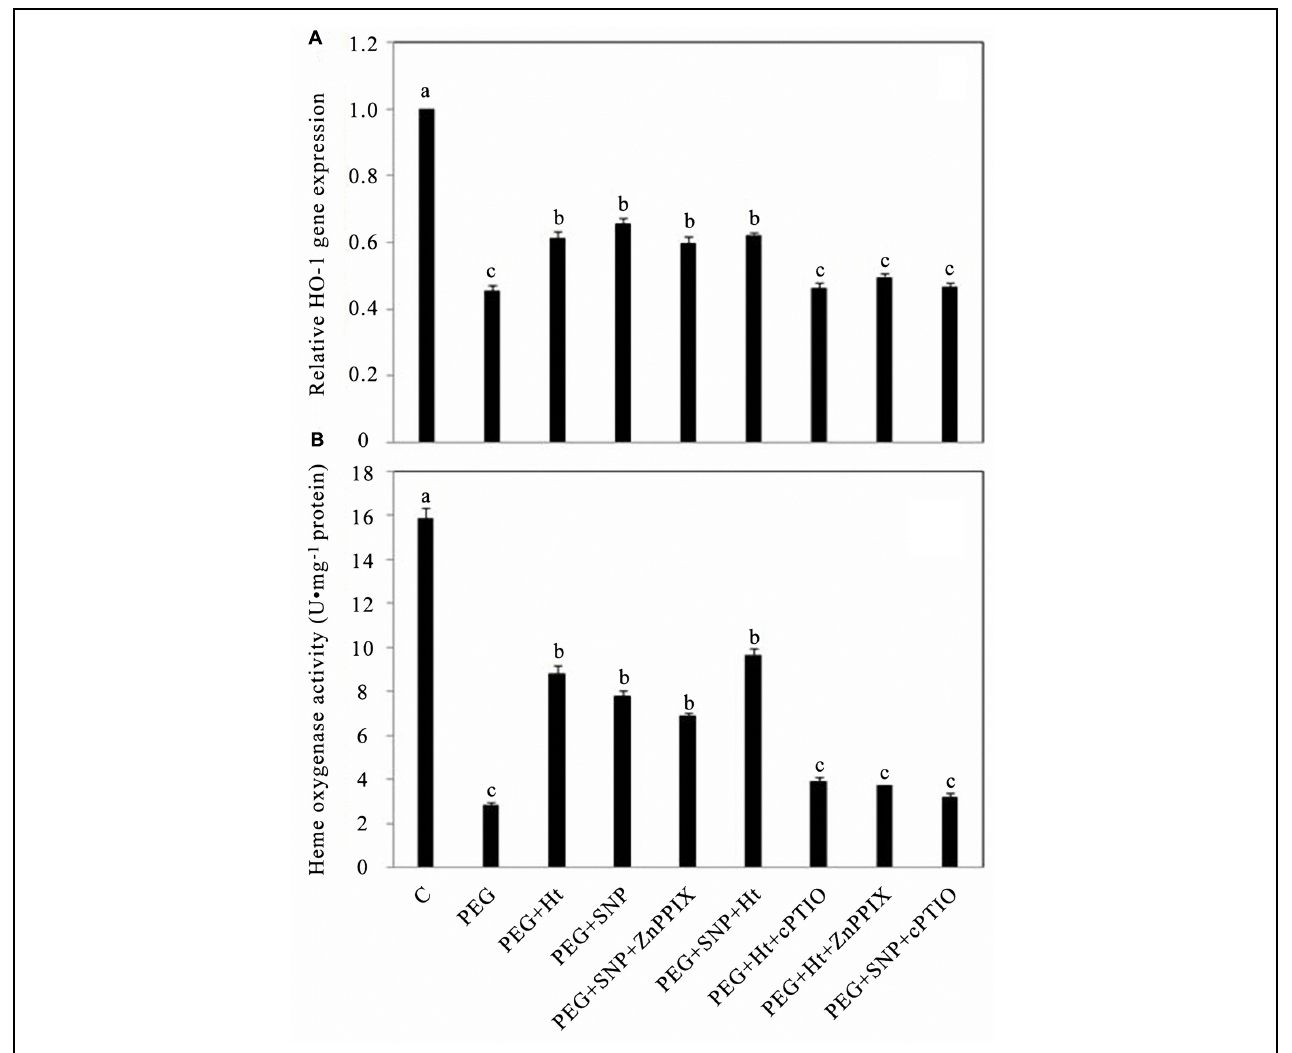
FIGURE 1 | Hematin (Ht), sodium nitroprusside (SNP), zinc protoporphyrin IX (ZnPPIX), and 2-(4-carboxyphenyl0-4, 4, 5, 5-tetramethylimidazoline-l-oxyl-3-oxide potassium salt (cPTIO) up- or down-regulated HO-1 gene expression (A) and HO activity (B) in rice aleurone layers subjected to drought stress. Rice aleurone layers were treated with or without 20% (polyethylene glycol-6000) PEG, 1 μ M Ht, 200 μ M SNP, 10 μ M ZnPPIX, 200 μ M cPTIO individually or in combination for 24 h. A sample with distilled water was used as control (C). Measurement of HO-1 transcript levels in the rice aleurone layers was conducted by real-time fluorescence quantitative PCR assay (A) , HO activities were also detected (B) . Mean values were calculated from at least three independent experiments, bars with different letters indicate statistically significant differences at the 0.05 level, using Duncan’s multiple